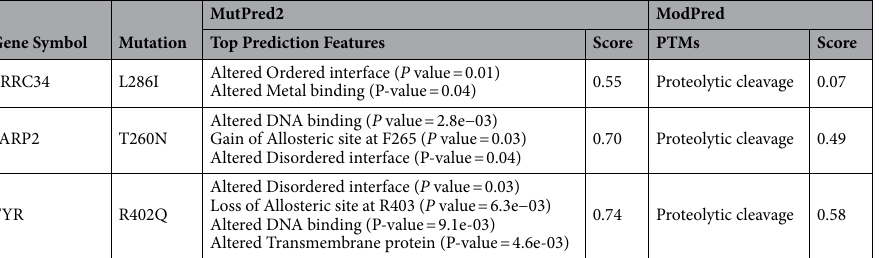
Table 7. Probability scores and top prediction features of deleterious mutations by MutPred2 and ModPred. MutPred2: P values < 0.05 = confident and P values < 0.01 = very confident; MutPred2 score < 0.5 = neutral